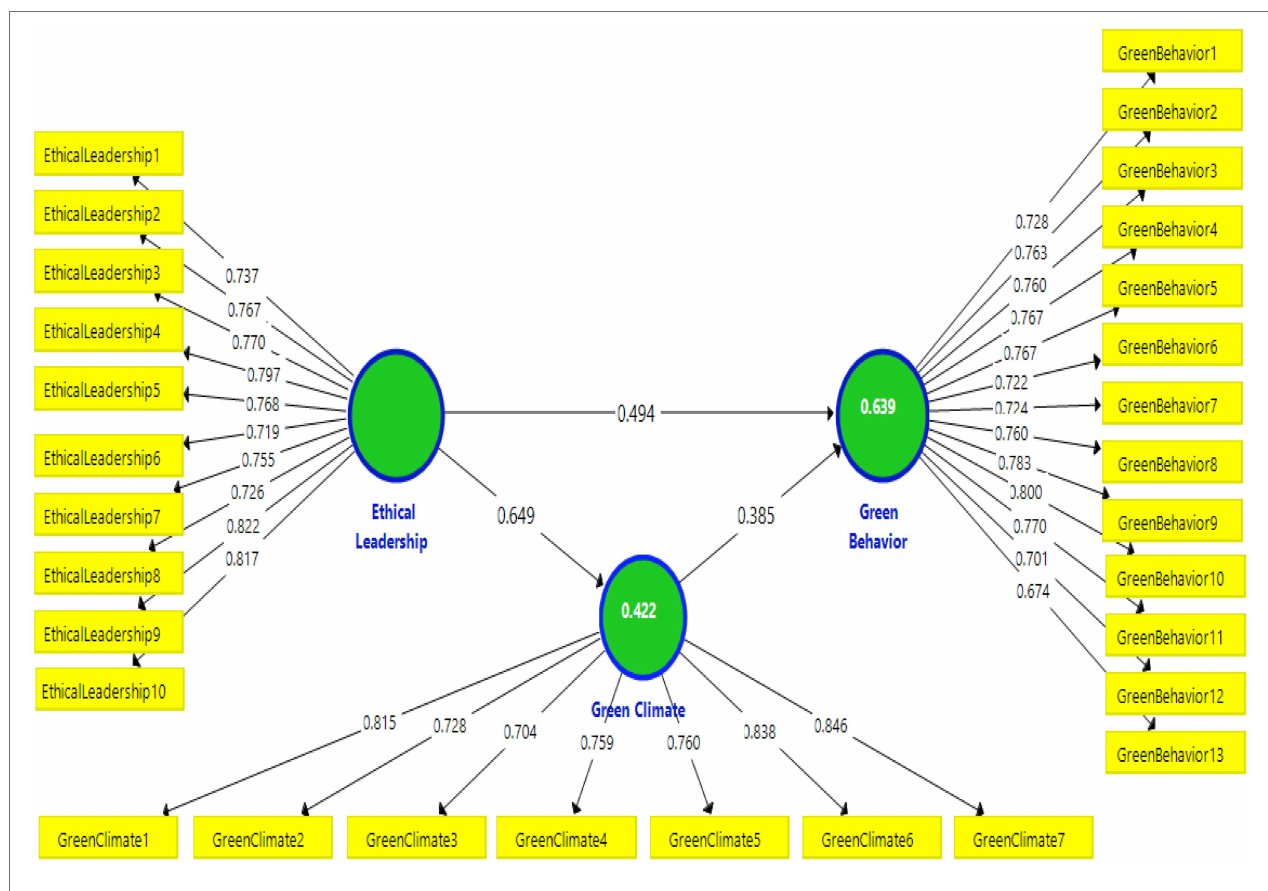
FIGURE 4 | Adjusted Measurement Mode.